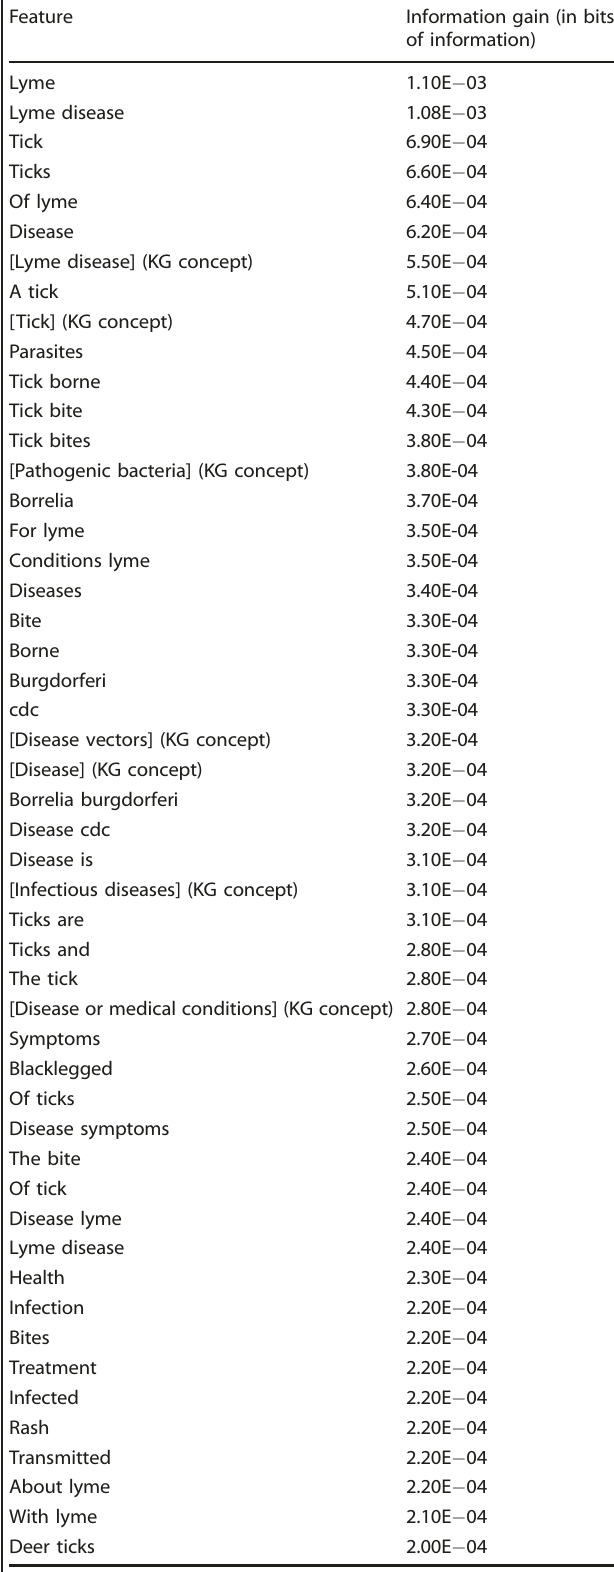
Table 2. Top 50 classi fi er features, ranked by information